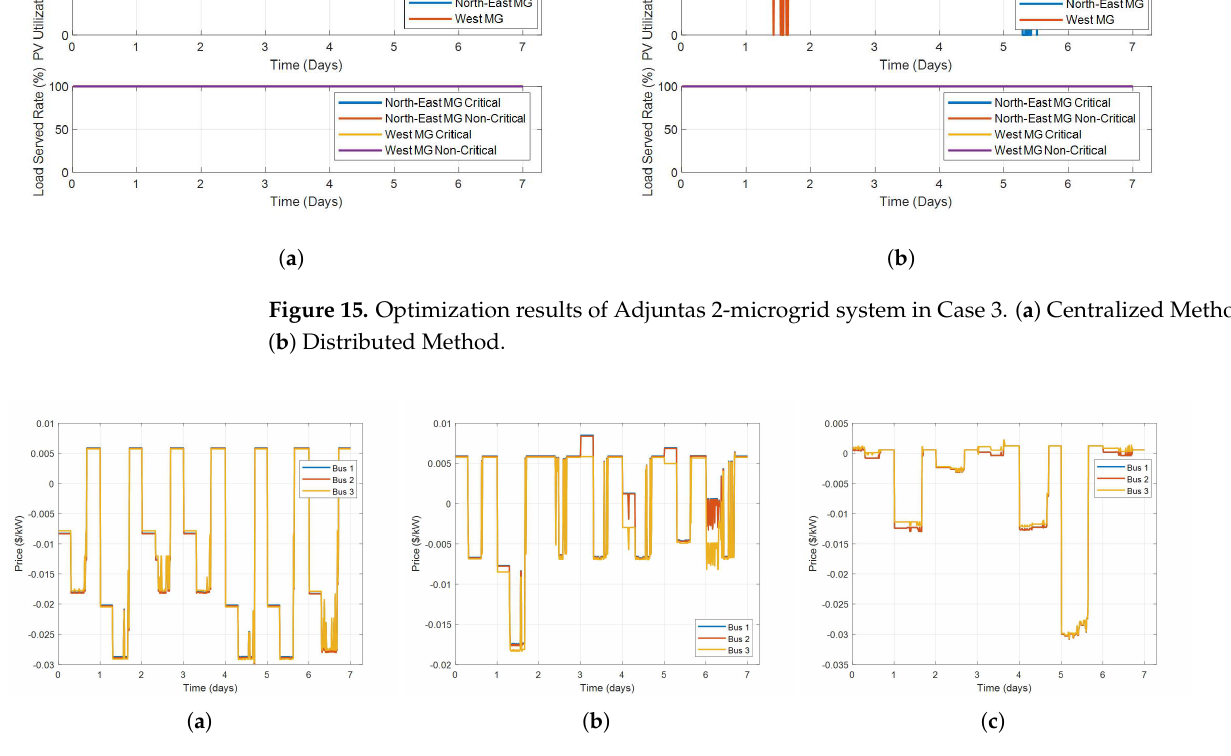
Figure 16. Calculated bus prices of Adjuntas 2-microgrid system in various cases. ( a ) Case 1. ( b ) Case 2. ( c ) Case